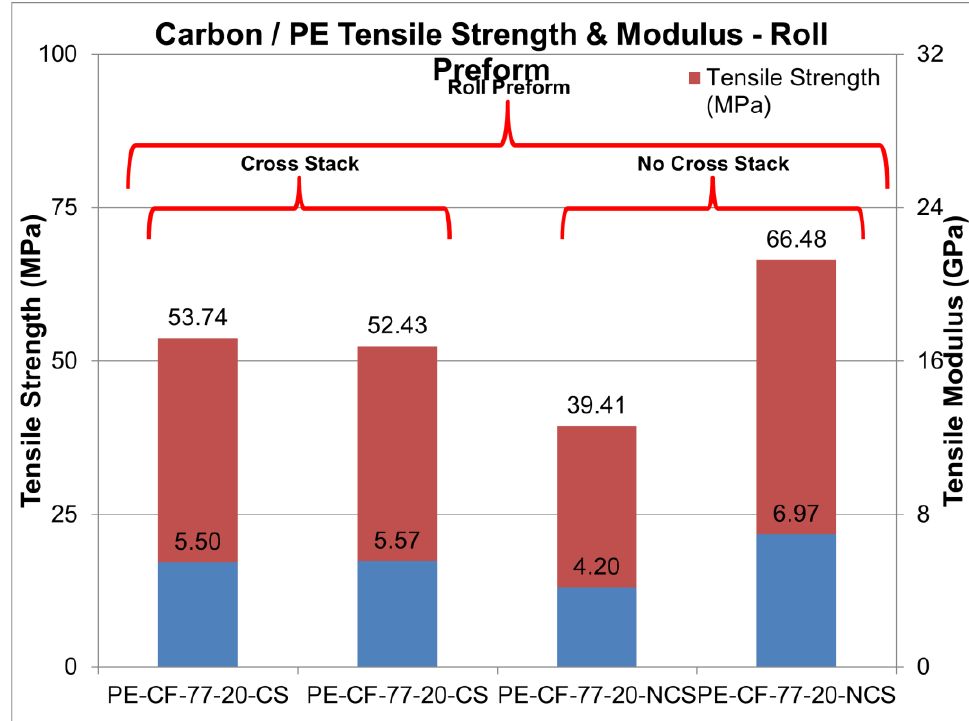
Figure 7. Comprehensive summary of tensile strength and tensile modulus for ‘roll’ form no stack and cross-stack — C/PE.